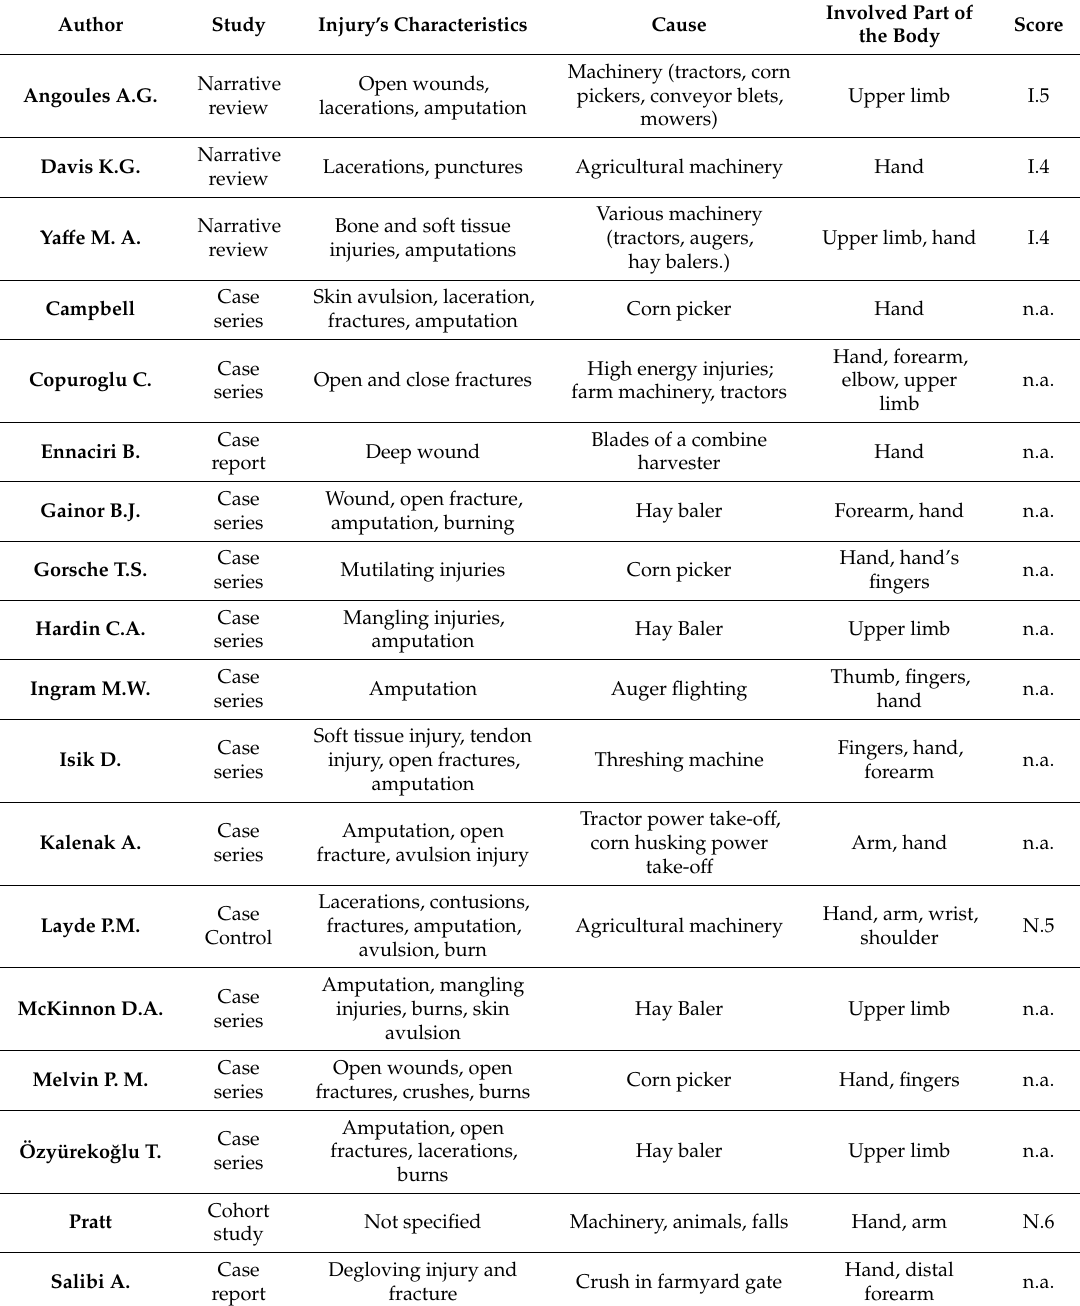
Table 2. Reviews, case series, case report, control, and cohort studies with relative